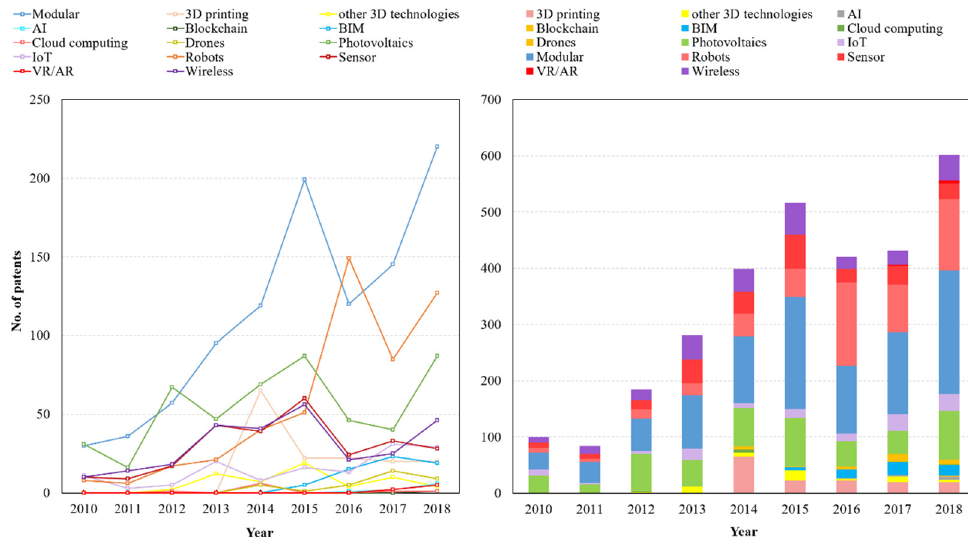
Figure 4. Trend for patent applications of the fourteen technologies during 2010–2018.